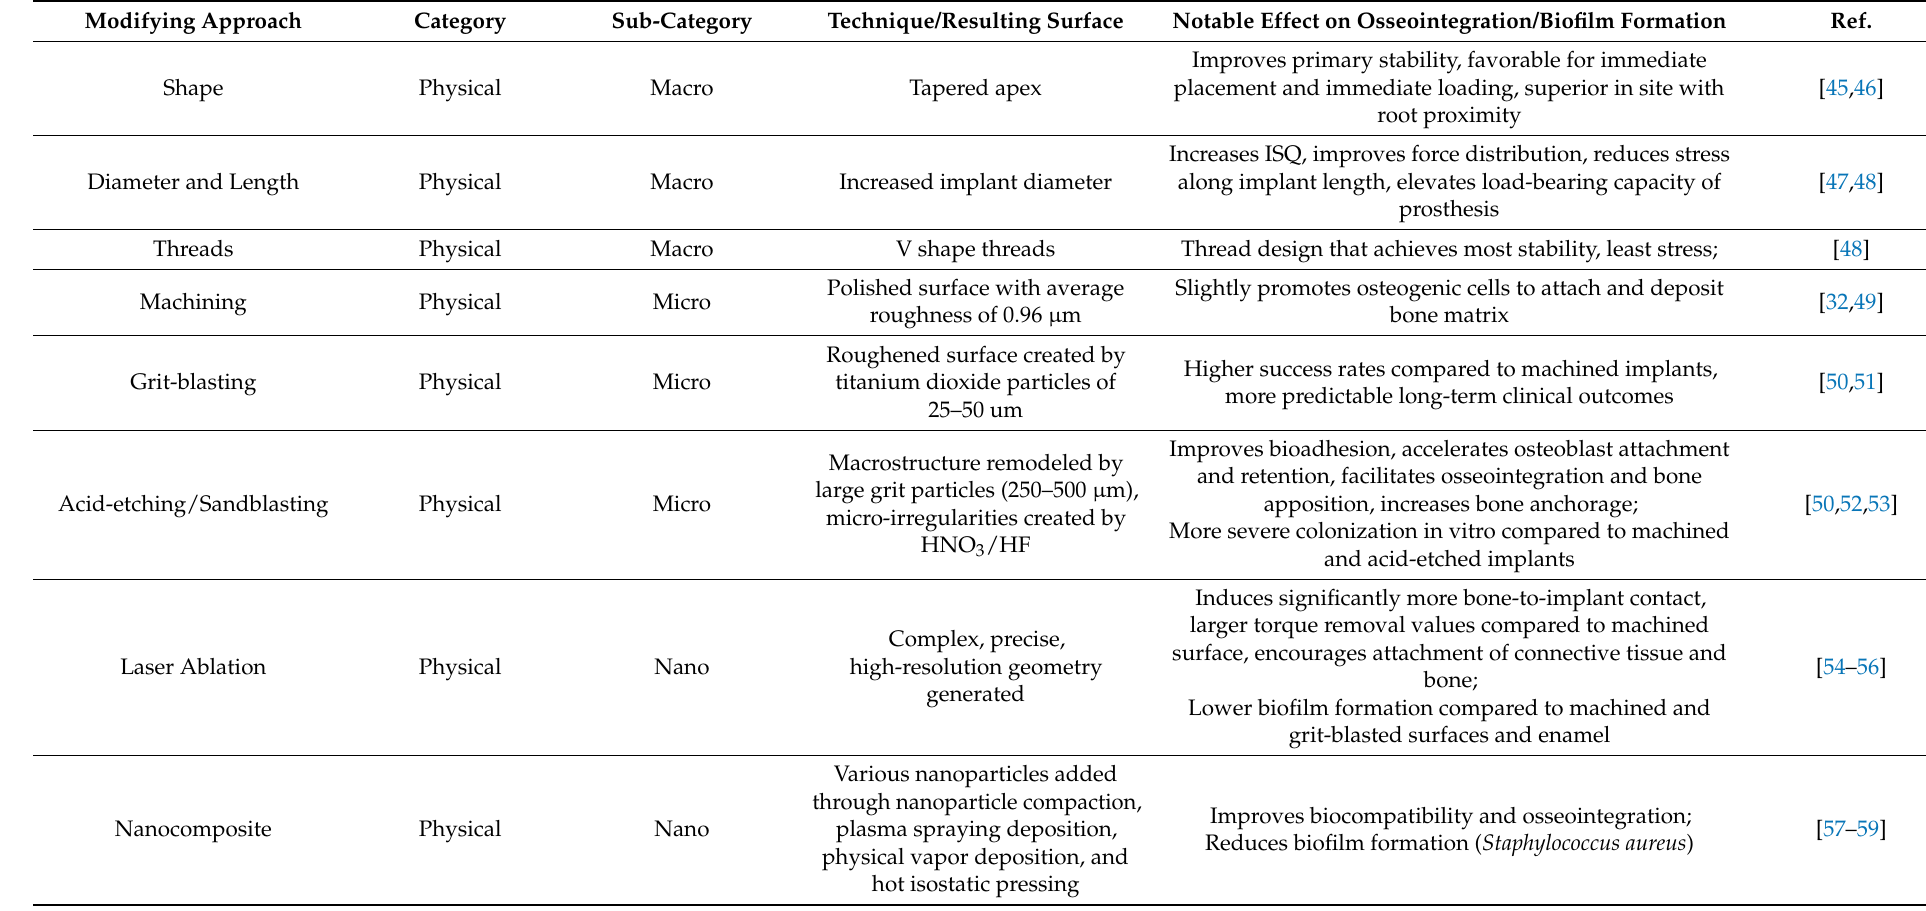
Table 1. The list of titanium implants’ surface modification